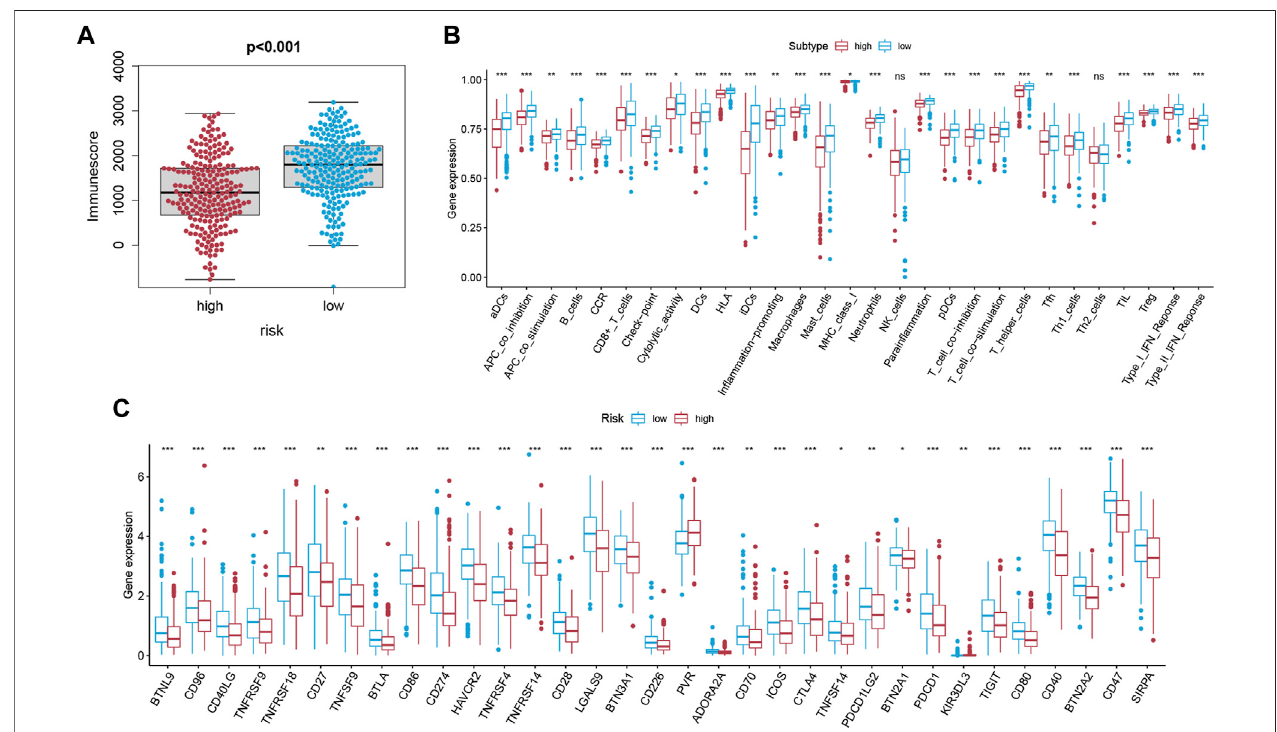
FIGURE 7 | Analysis of the immune status of LUAD. (A) The correlation between the risk score and the immune score was displayed ( p < 0.001). (B) Differential distributionofenrichmentscoresof16immunecellstypesand13immune-relatedpathwaysbetweenthelow-risk(bluebox)andhigh-risk(redbox)groupsviassGSEA. (C) Boxplots of the expression level of ICGs between the two subgroups (low-risk: blue; high-risk: red). Only the expression level of PVR was positively correlated to the risk